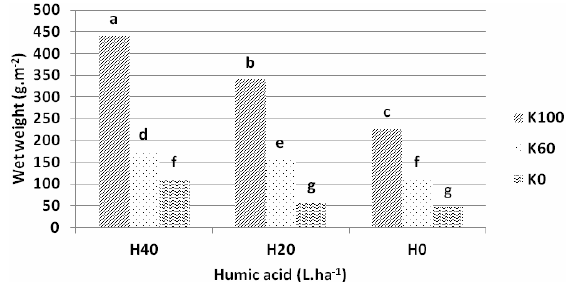
Fig. 1. Effect of humic acid and potassium sulphate on wet weight in the first cutting